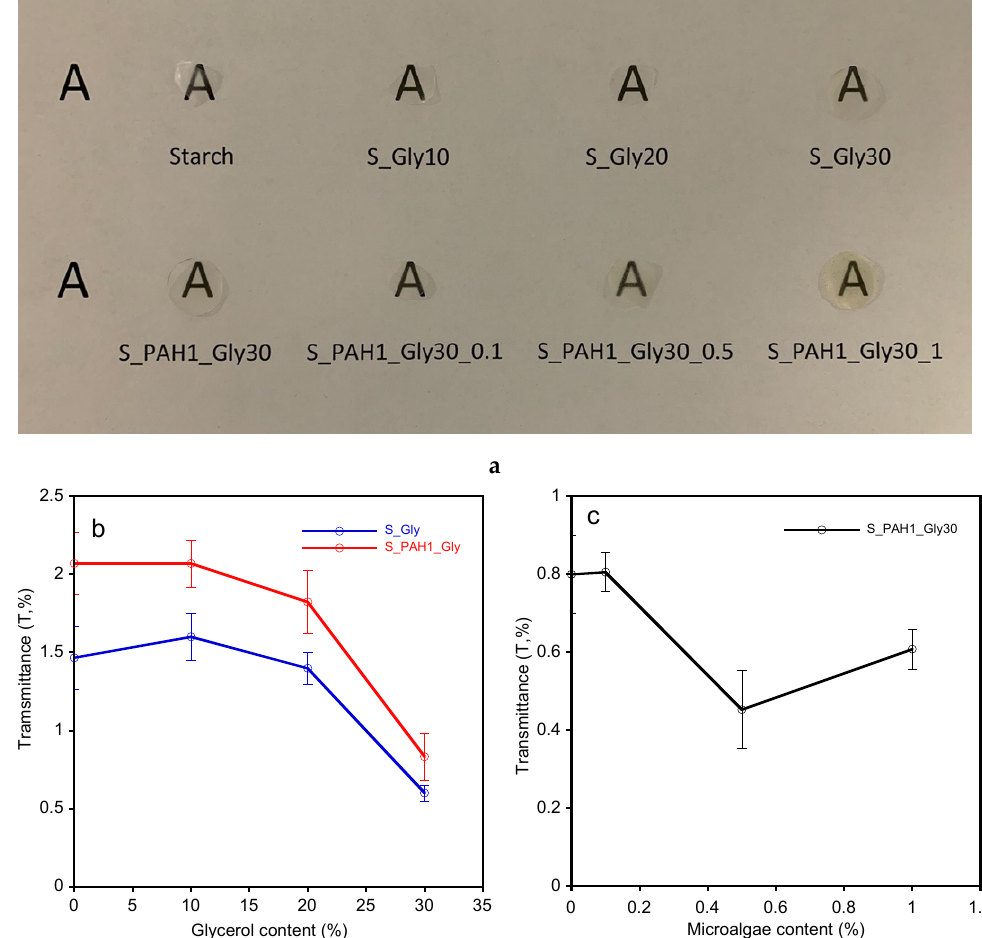
Figure 3. Film transparency properties. Digital images of films obtained with different formulation ( a ); Transmittance of films as a function of glycerol content with or without 1% w PAH ( b ); Transmittance of S_PAH1_Gly30 film as a function of microalgae content (0.1, 0.5 and 1%) ( c ).